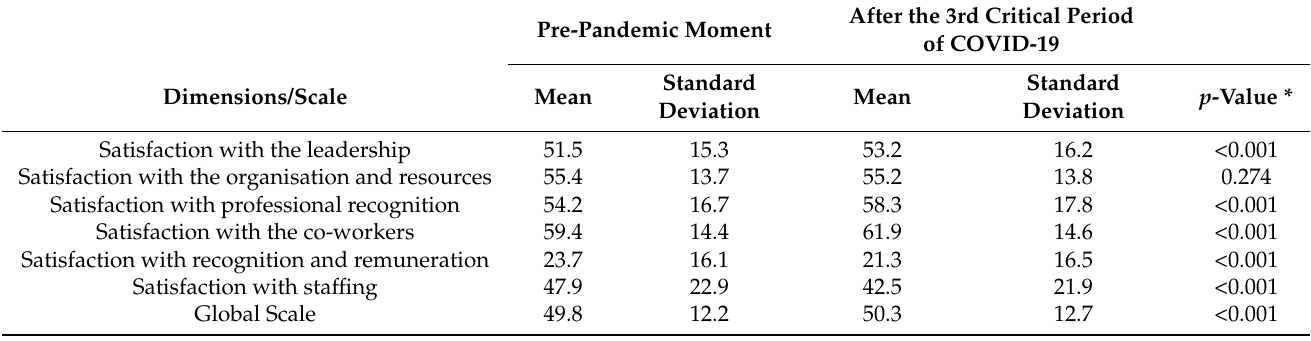
Table 2. Mean scores of nurses’ job satisfaction at the pre-pandemic moment and after the 3rd critical period of COVID-19. After the 3rd Critical Period Pre-Pandemic Moment of COVID-19 Standard Standard Mean Mean Deviation Deviation